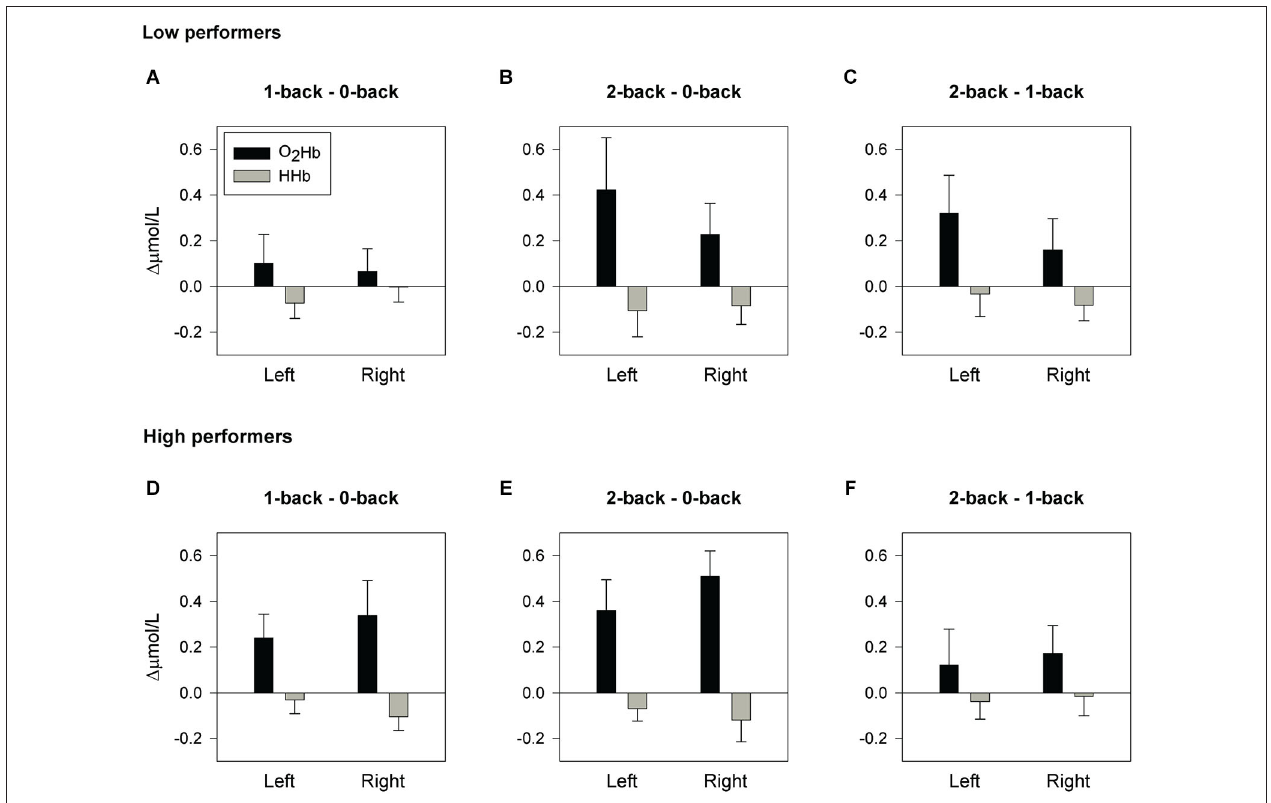
and 2-back minus 1-back contrast. (A) , (B) and (C) display the results for low performers. (D) , (E) and (F) display the results for high